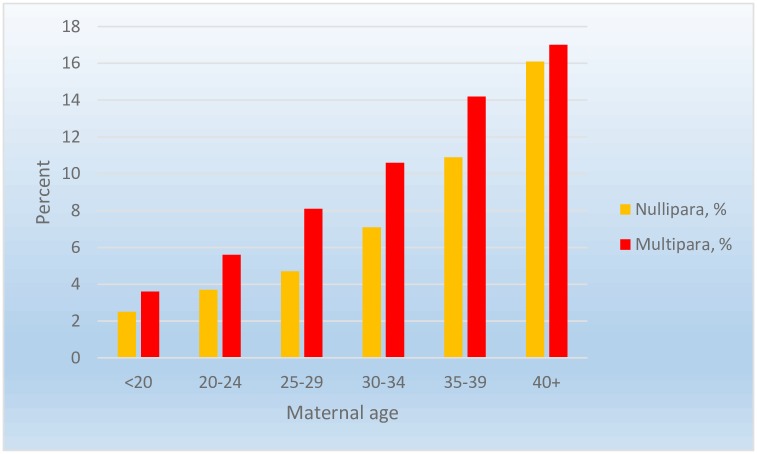
Unadjusted risk of planned cesarean section.Stratified by parity and age (years).